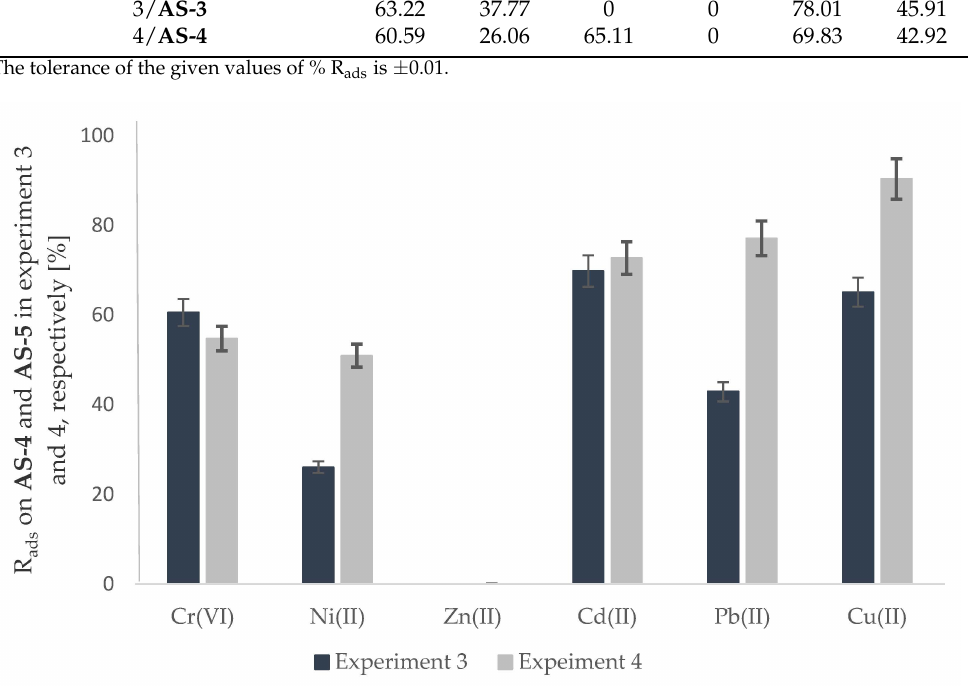
Figure 4. Sorption of metal ions on the active substrate ( AS-4 and AS-5 ) according to Experiments 4 and 5,